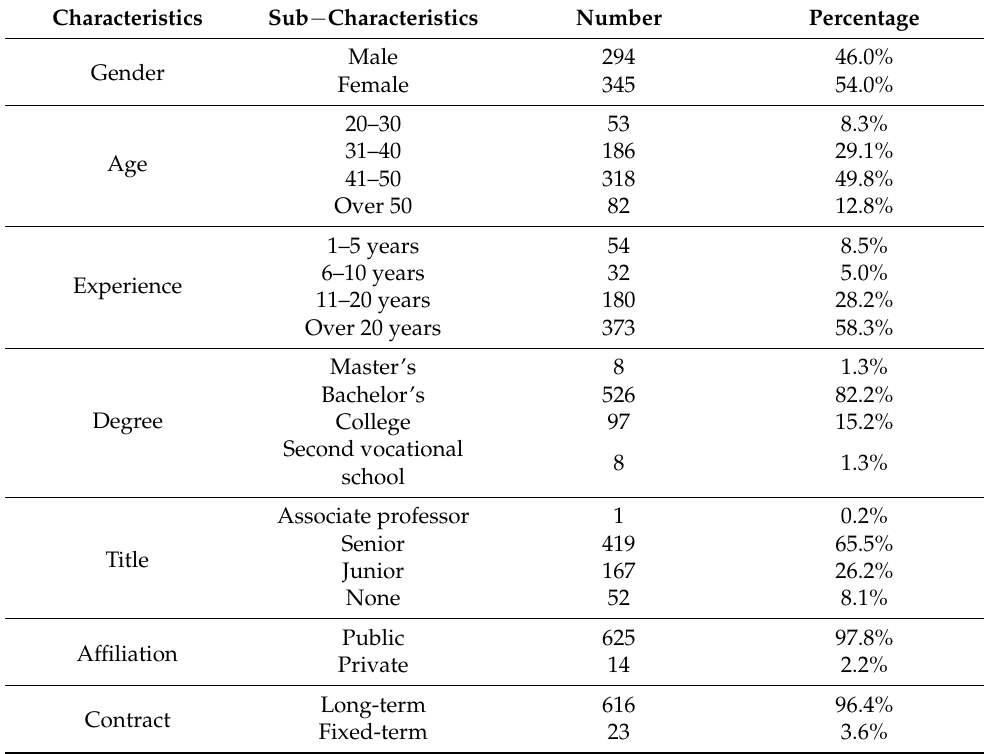
Table 1. Participants’ characteristics.